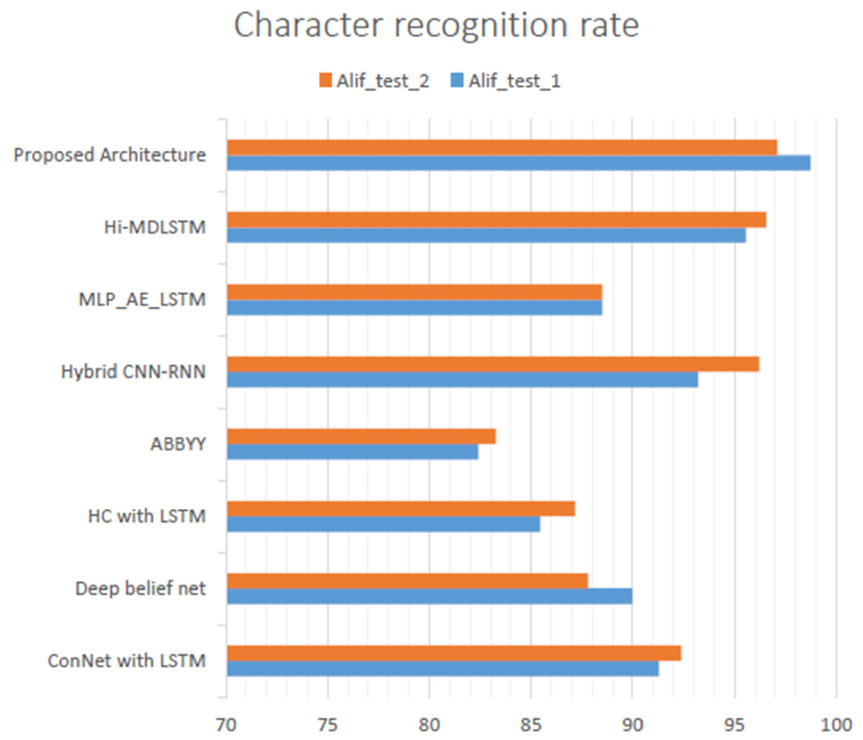
Figure 14. Comparison of proposed architecture with different architectures on character recognition rate (Alif dataset).